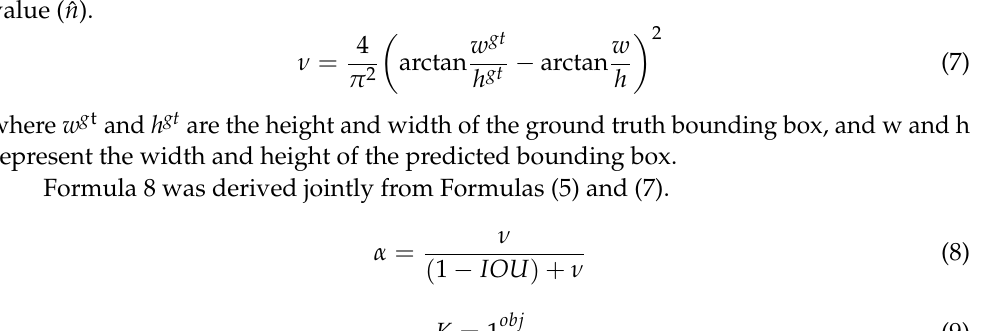
where BCE represents the cross-entropy loss function of the true value ( n ) and the predicted value (ˆ n ).